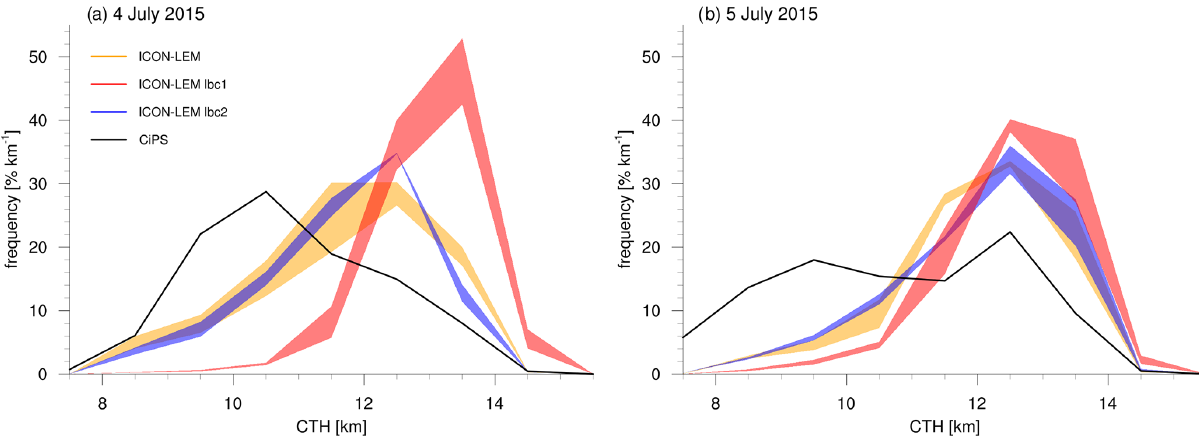
Figure 9. Similar to Fig. 6, but displaying the change in CTH when varying the initial conditions for 4 July 2015 (a) and 5 July 2015 (b) .